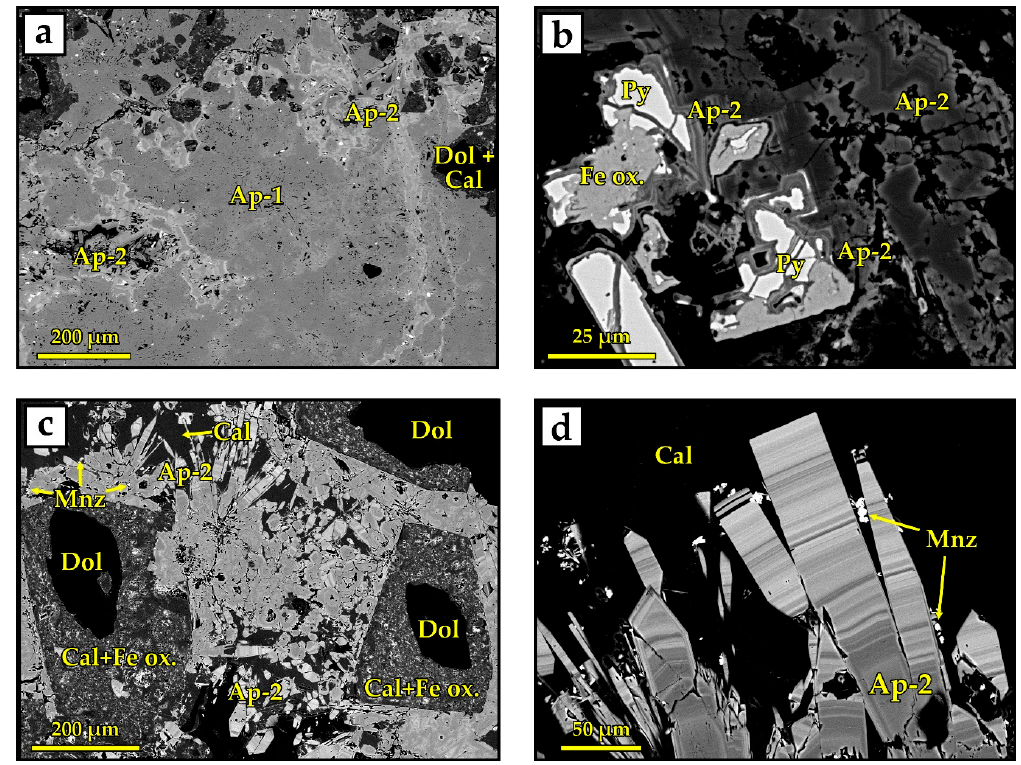
Figure 6. Apatite in high-Ti carbonatite. ( a ) Clusters of porous anhedral grains of the early apatite (Ap-1) and late zoned apatite (Ap-2), bordering Ap-1, as veinlets and cavity-fillings. ( b ) Concentrically banded Ap-2 rims around pyrite grains. ( c ) Radial aggregates of small euhedral Ap-2 crystals. Dolomite in contact with Ap-2 is replaced by calcite and included with Fe-hydroxides. ( d ) Ap-2 with a horizontal fine oscillatory zoning pattern (light gray bands—with Na + REEs; dark gray—with Sr + S) and monazite (small white crystals). All photomicrographs are BSE images. In contrast, the composition of both the rims and idiomorphic crystals of late apatite Ap-2 is highly variable, even within a single grain. On the BSE images, this compositional variability is expressed as fine oscillatory zoning (Figure 6d). In Ap-2, SO 3 content varies in the range of 0.4–1.3 wt. %, SrO concentration reaches 3.0 wt. %, Na 2 O reaches 3.0 wt. %, and ThO reaches 0.9 wt. %. Total